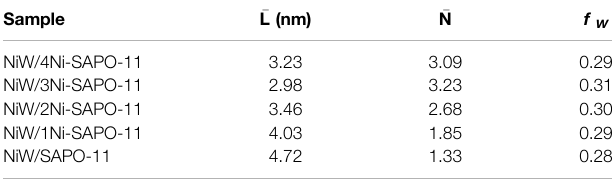
TABLE 4 | Average lengths, layer numbers, and f W values of WS 2 of all catalysts.